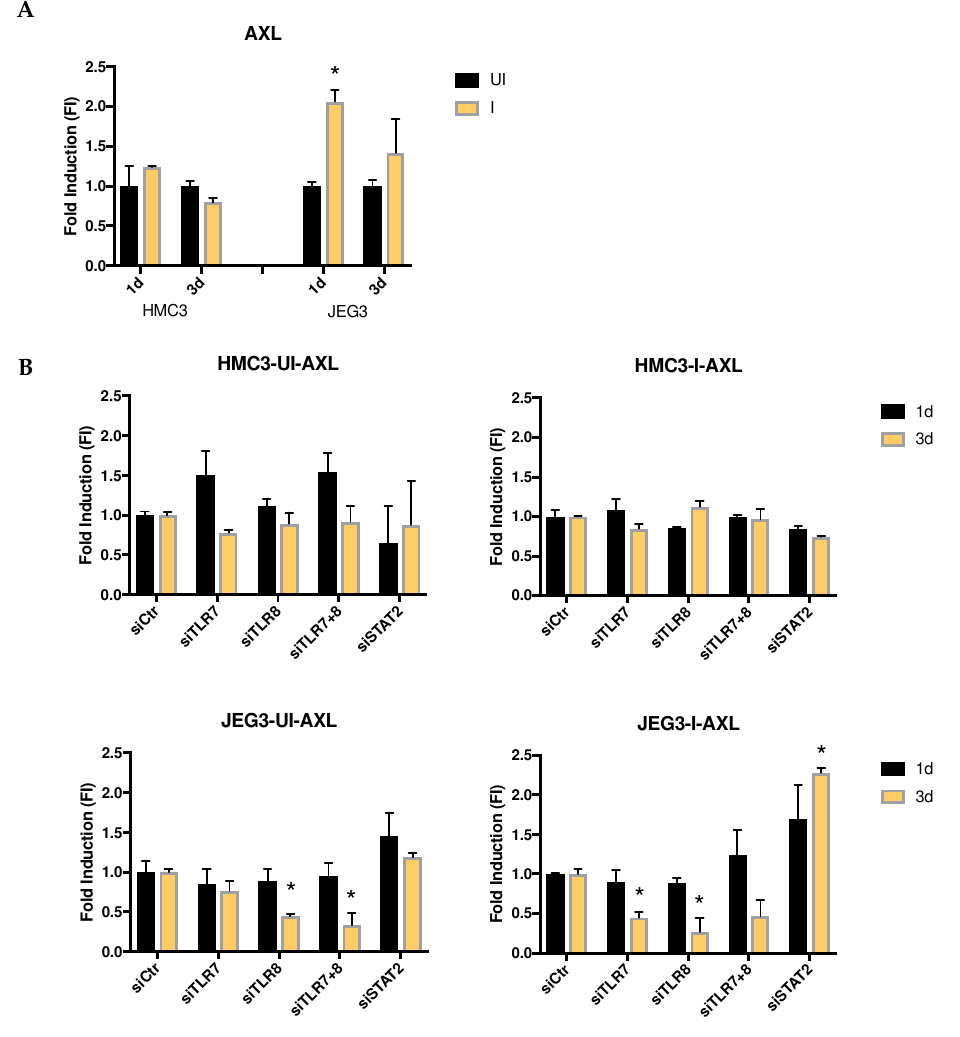
Figure 7. Role of AXL in ZIKV infection. ( A ) AXL fold induction ZIKV-infected (I) relative to time-matched mock-infected (UI) HMC3 and JEG-3 cells at one dpi and three dpi. ( B ) Effect of siRNAs targeting TLR7, TLR8, TLR7 + TLR8, or STAT2 on AXL expression in time-matched mock-infected (UI) and ZIKV-infected (I) HMC3 and JEG-3 cells at one dpi and three dpi. (* p < 0.05). Error bars represent standard deviation.